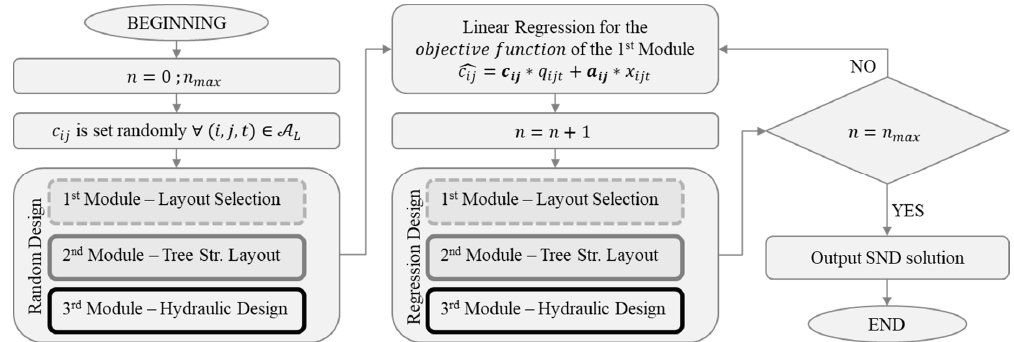
Figure 5. Sewer networks design (SND) problem flow chart.